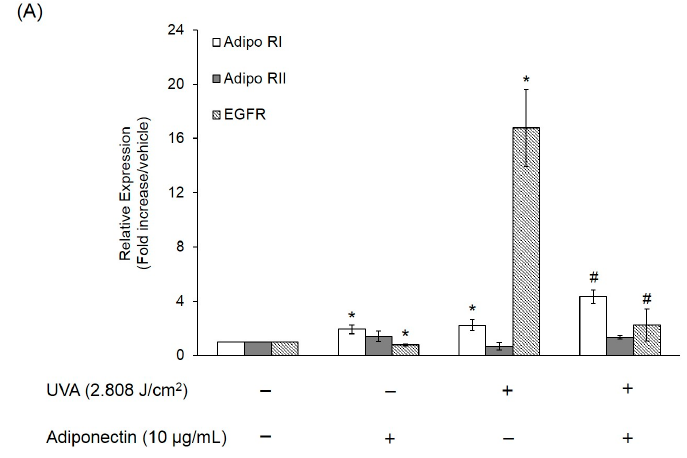
Figure 7. Cont. Figure 7.